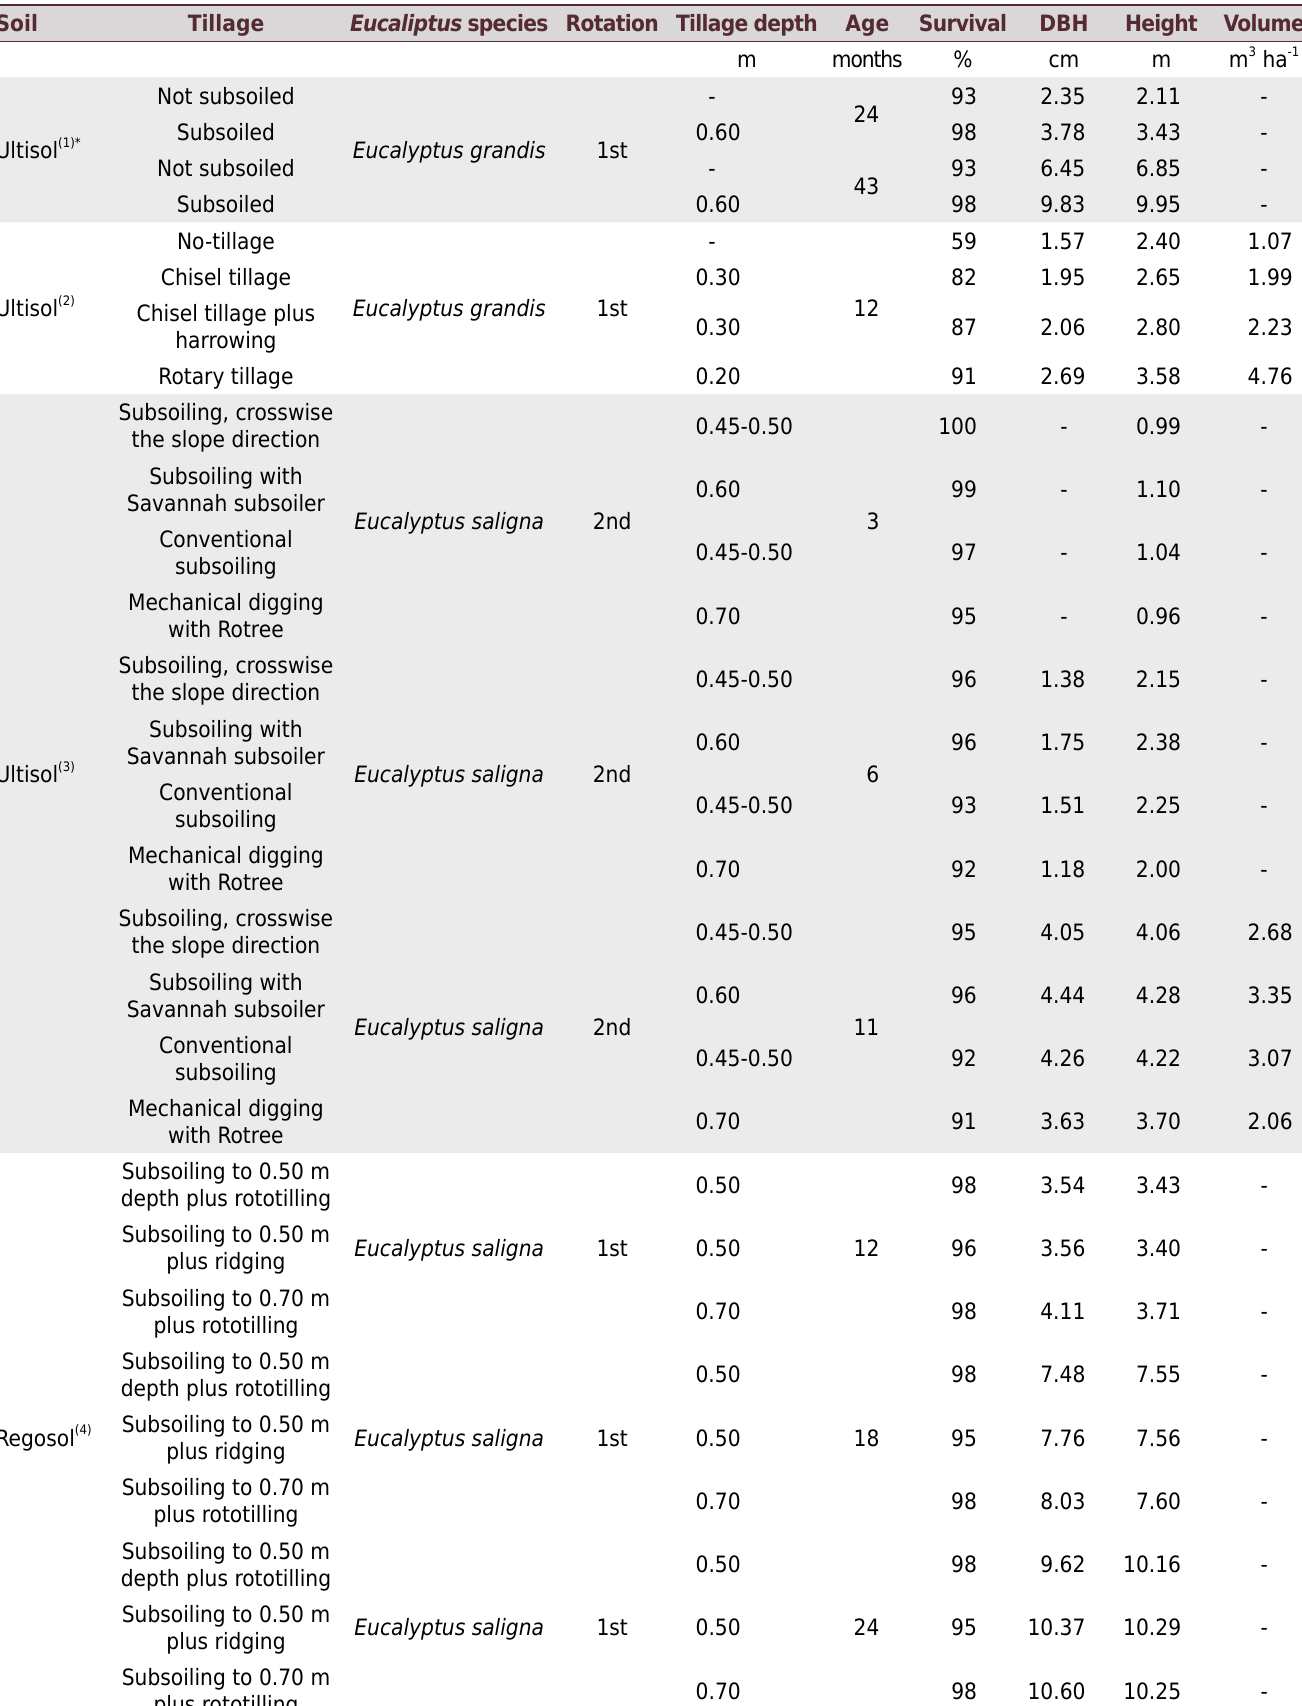
Table 2. Eucalyptus spp growth (seedling survival, and tree diameter at breast height DBH, height, and volume) in different soils and tillage type and depth, in first and second planting rotations Soil Tillage